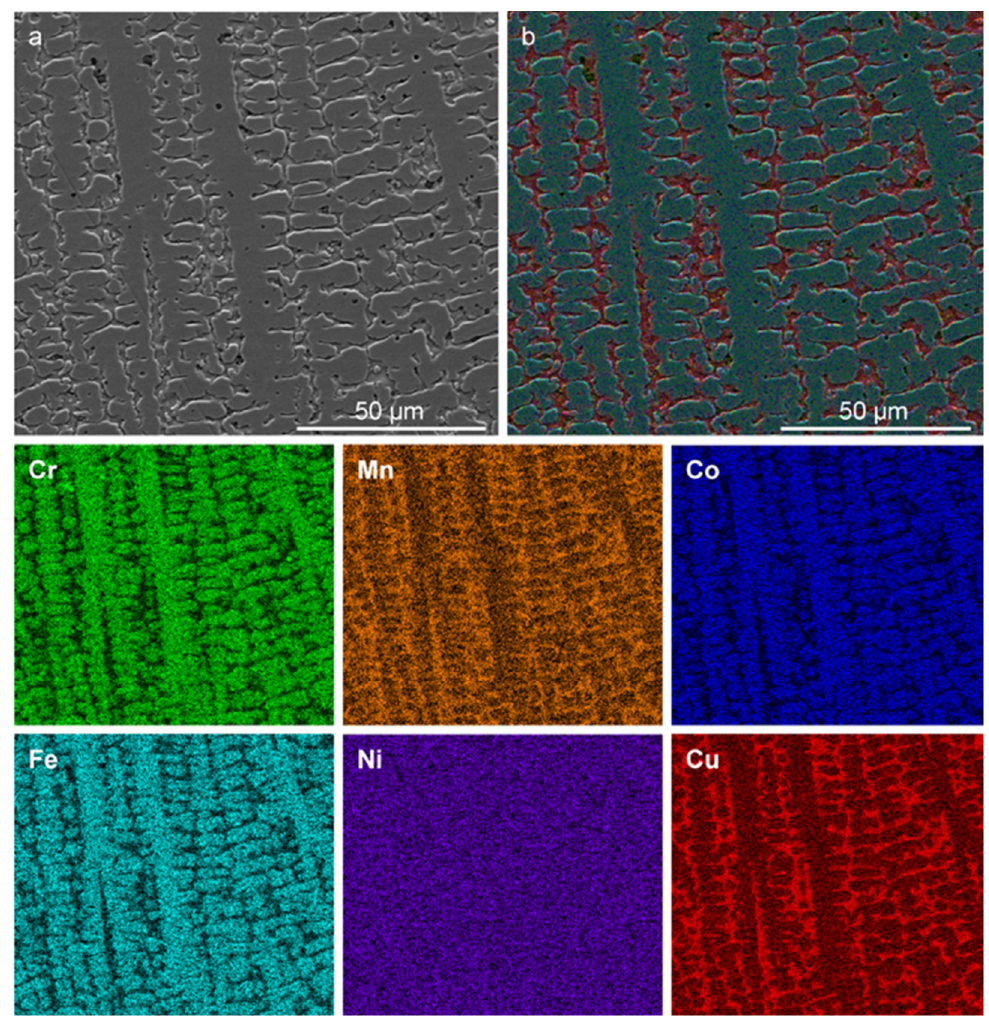
Figure 2. Microstructure of as-cast CrMnFeCoNiCu alloy. ( a ) SEM micrograph showing dendritic as-cast structure and ( b ) layered SEM+EDS elemental map along with elemental maps of the constituent metals.